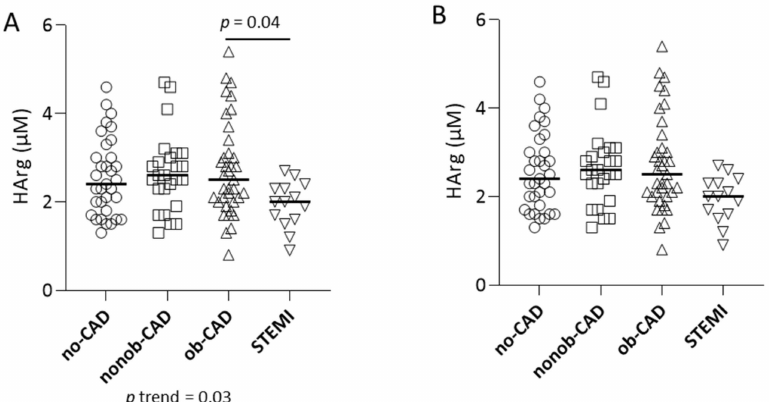
Figure 4. ( A ) Levels of HArg in plasma from no-CAD (o), nonob-CAD ( (cid:3) ), ob-CAD ( (cid:52) ), and STEMI ( (cid:53) ) patients (raw data); ( B ) levels of HArg in plasma from no-CAD, nonob-CAD, ob-CAD, and STEMI patients, adjusted for age and sex. Data are represented using a scatter dot plot; horizontal lines show median value.